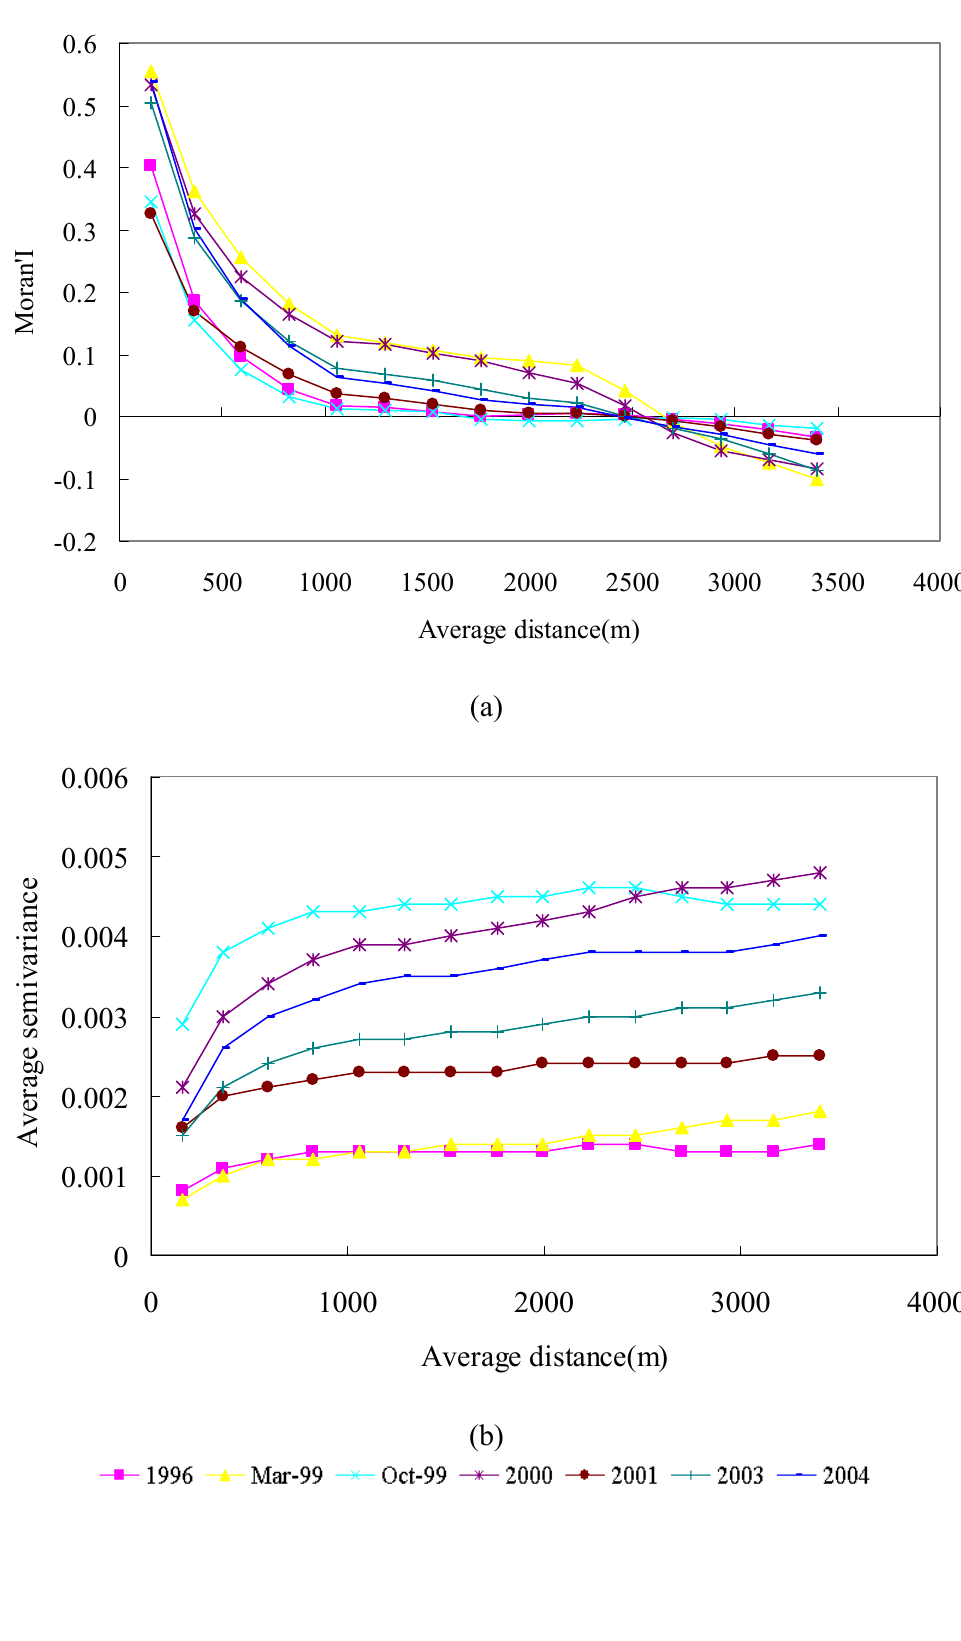
Figure 6. (a) Moran’I and (b) experimental variograms of NDVI images before and after disturbances in the